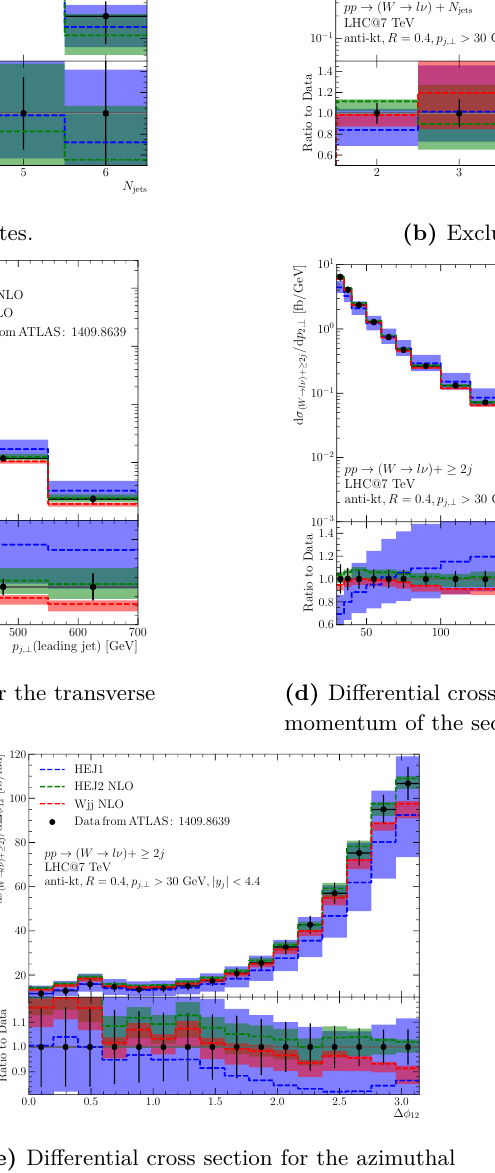
(e) Differential cross section for the azimuthal angle between the two leading jets. Figure 17. Predictions for pp → ( W → lν )+ ≥ 2 j for LHC@7TeV, compared to ATLAS data from [14]. The original HEJ1 predictions are shown in blue, the pure NLO predictions are shown in red and the new HEJ2 predictions incorporating the methods of sections 3 and 4 are shown in